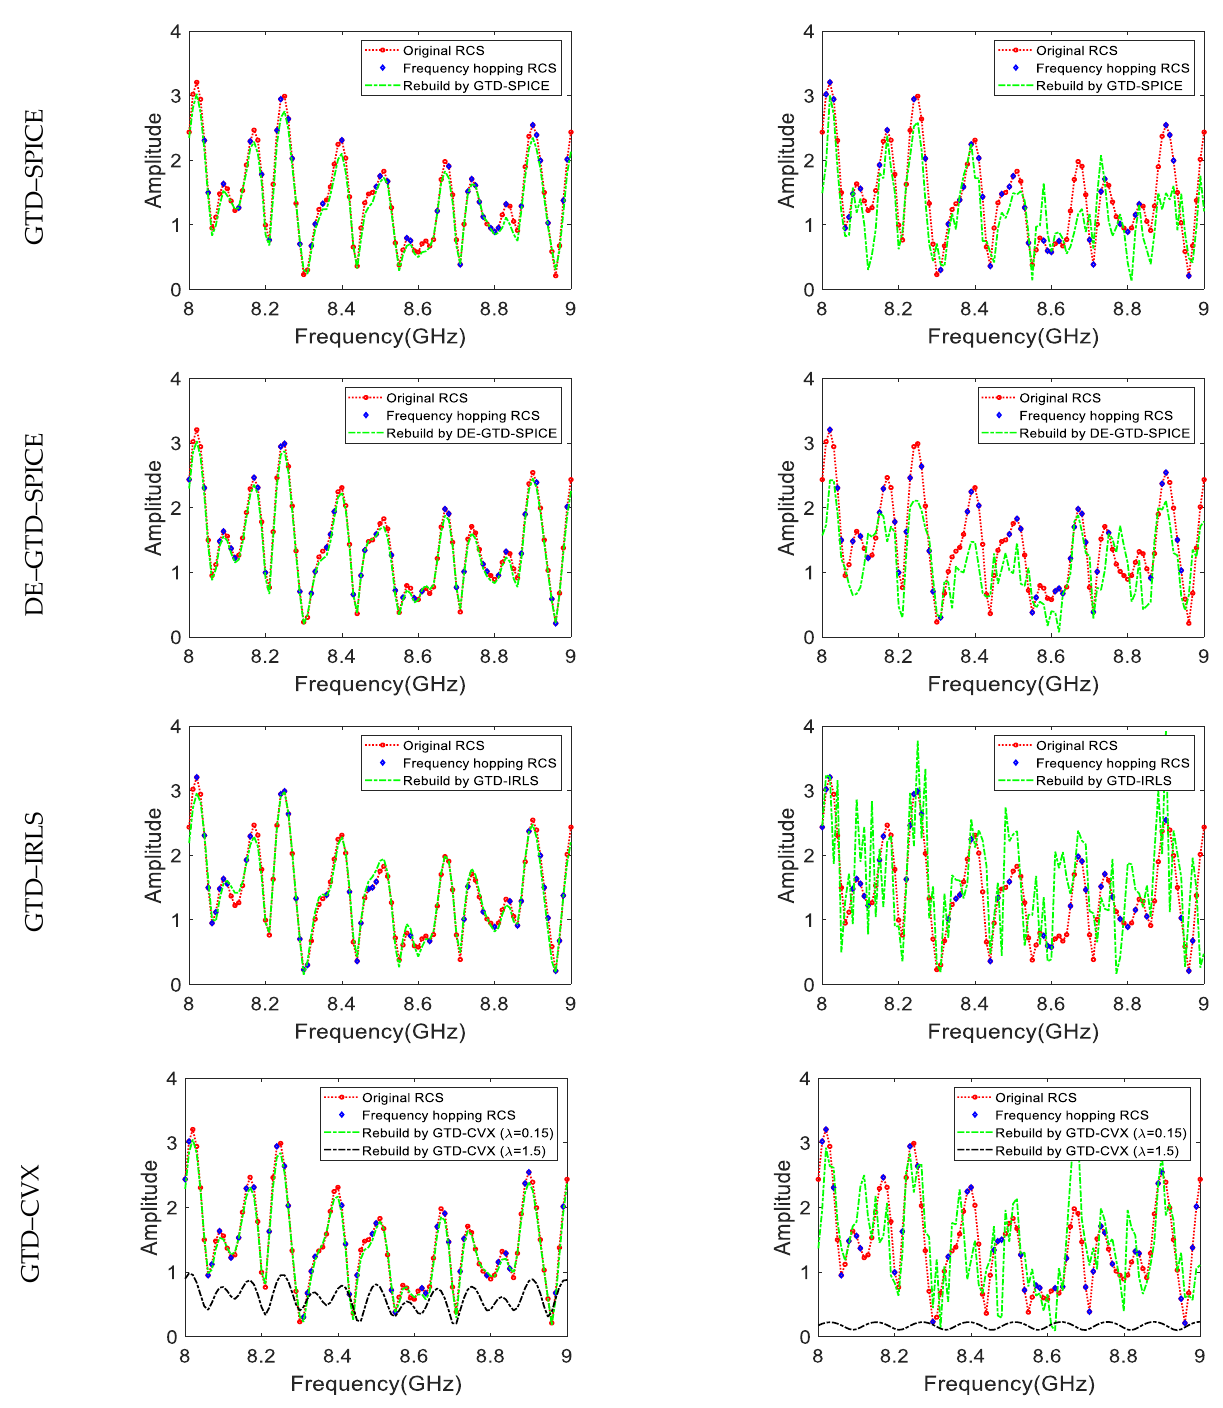
Figure 6. Amplitude of the reconstructed RCS sequence using the GTD–SPICE, DE–GTD–SPICE, GTD–IRLS, and GTD–CVX methods. In this case, FHR = 60%, η = 0.1, and L Coarse = L Fine = 2 in the DE–GTD–SPICE